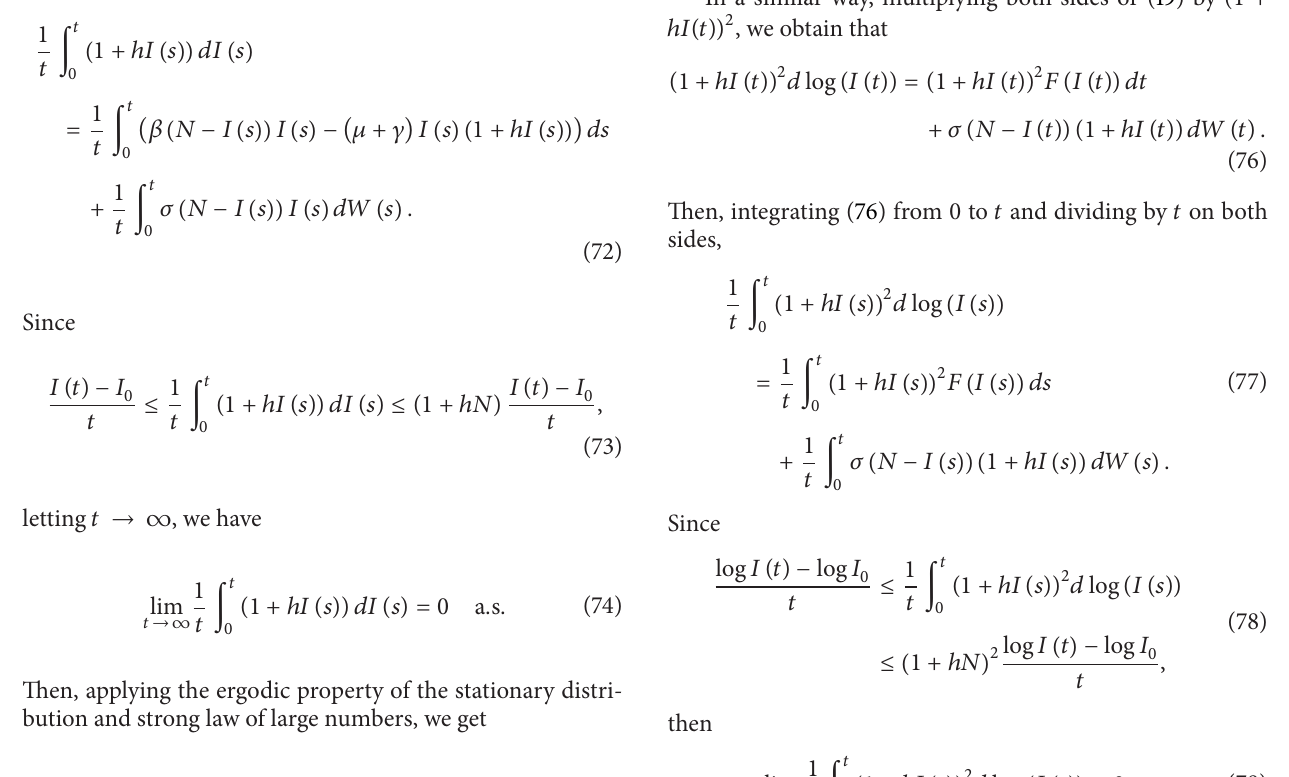
Integrating (71) from 0 to 𝑡 and dividing by 𝑡 on both sides,